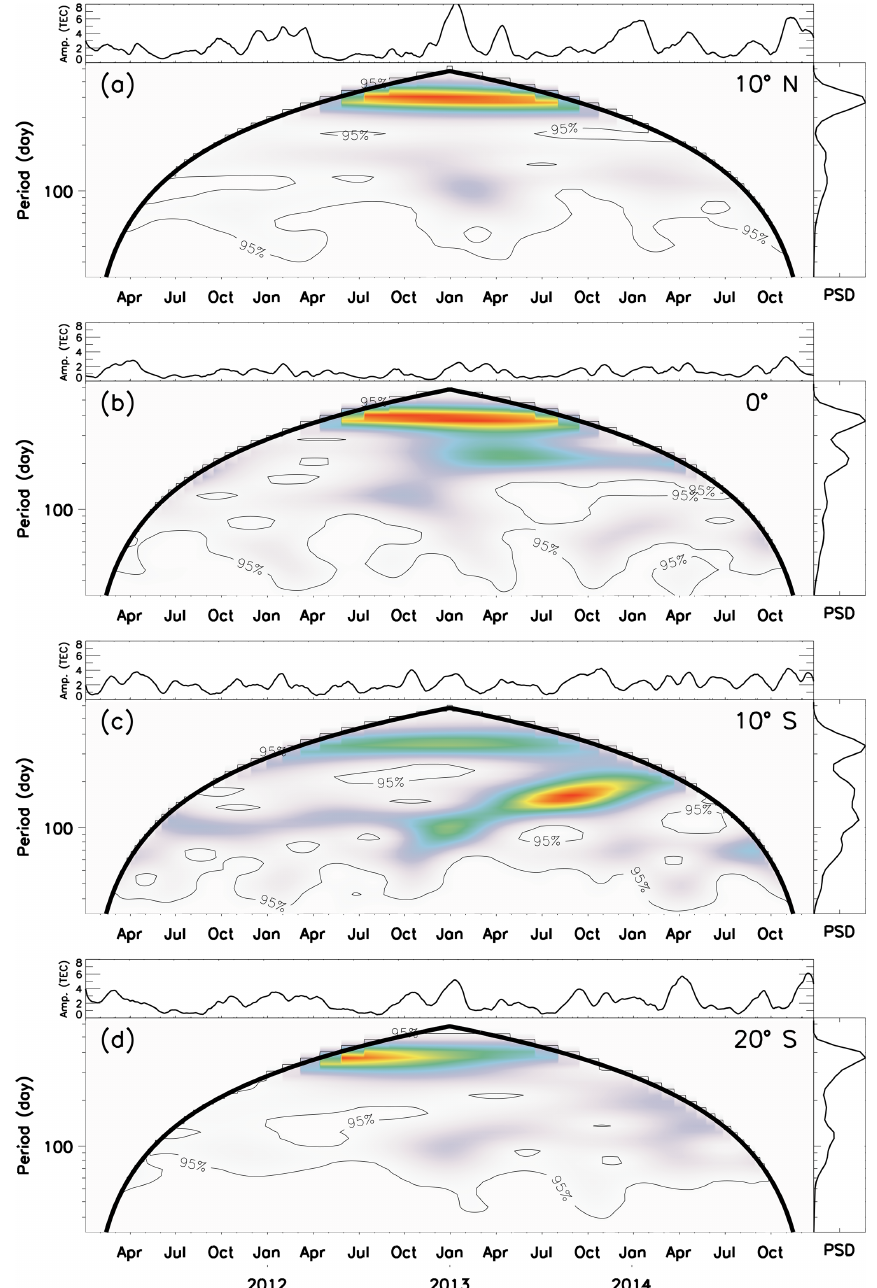
Figure 4. Wavelet analysis for (a) 10 ◦ N, (b) 0 ◦ , (c) 10 ◦ S and (d) 20 ◦ S. The heavy black lines in the contours represent the cone of influence. The light black lines show confidence levels of